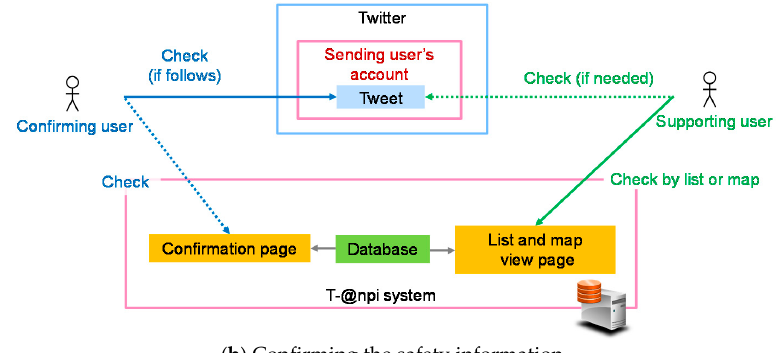
Figure 1. Outline of the proposed system.